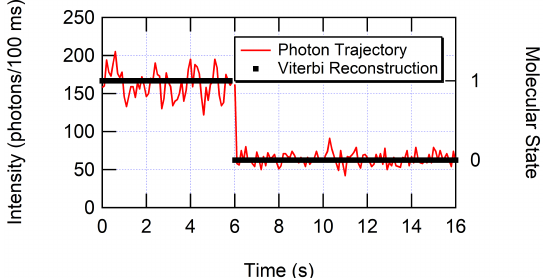
Figure 3. Photon arrival times are binned into a histogram with 100 ms bins to create the photon trajectory. A Viterbi algorithm is computed to determine the most likely molecular state pathway through the photon